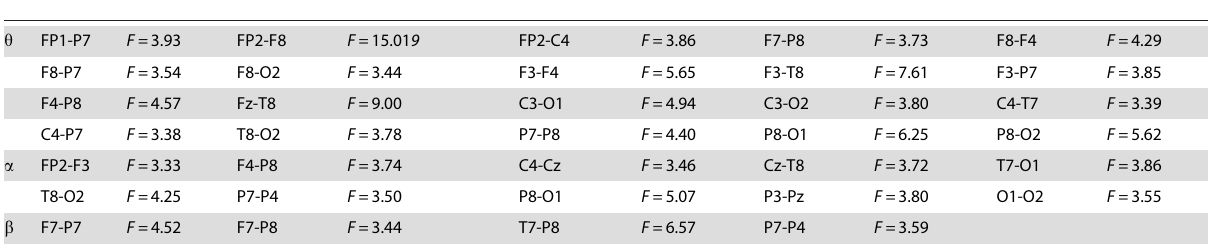
Table 2. Significant Results of F-test and Tukey Test of Coherence (p , .05).